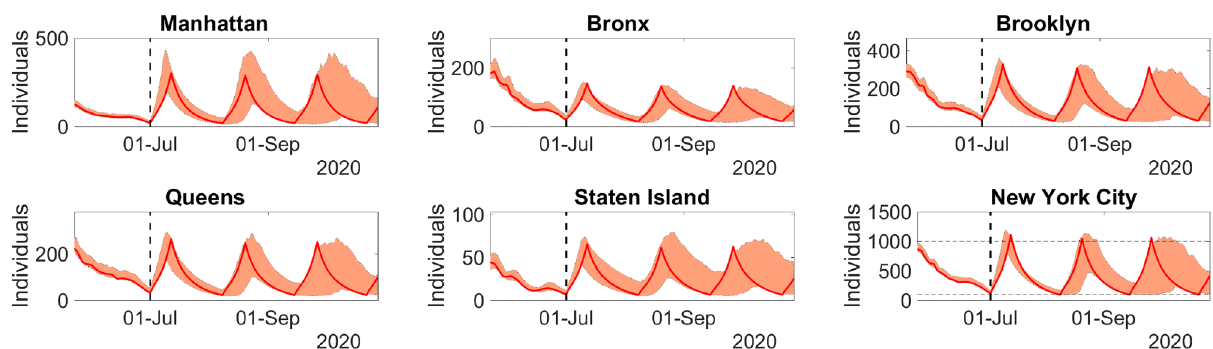
Figure 7. Model predictions of daily new infections for the period 02-July-2020 to 29-Oct-2020 in NYC, when lockdown is lifted, with light containment measures. The filled envelopes represent the 90% CIs. Figure generated with MATLAB R2019b